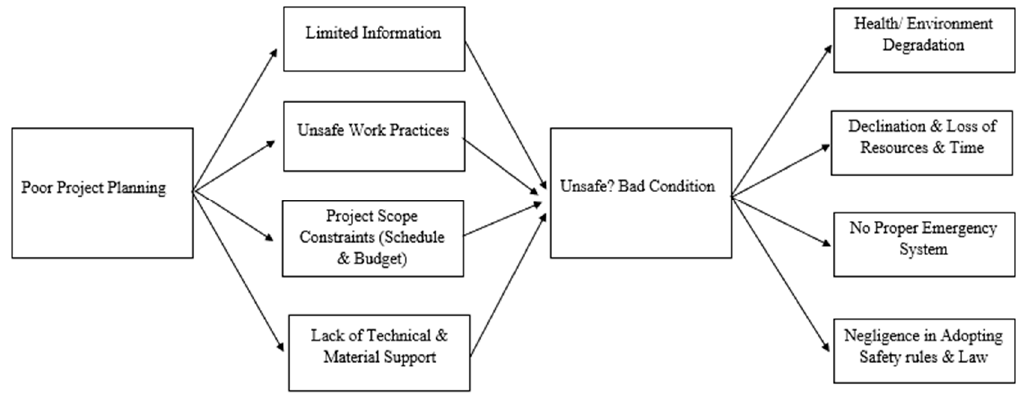
Figure 2. The Developed framework of health & safety factors of (OLMT-project).